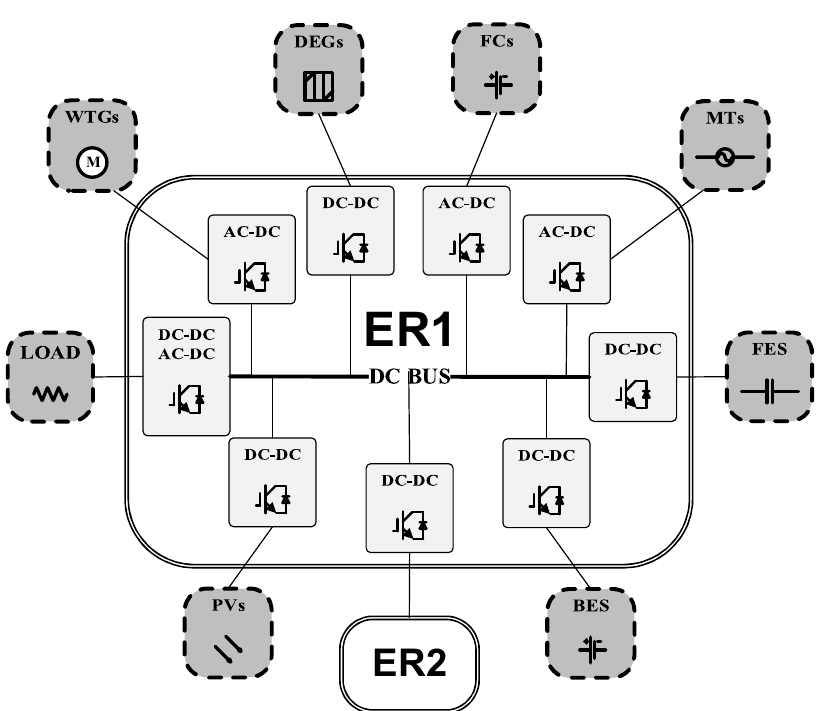
Figure 1. The studied energy router (ER) system.